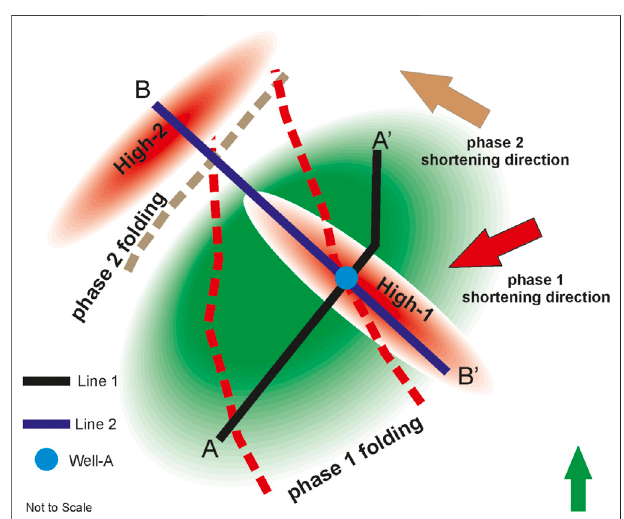
FIGURE 10 | Schematic drawing of the structural components of study area. Red dotted line represents phase 1(12.2 – 8.95 Ma) fold axes that trend roughly North – South. Brown dotted line represents the phase-2 (8.2 – 0.0 Ma) folding axes which trends southwest-northeast. Phase 1 shortening direction istowards thesouthwest, phase 2 shortening direction isnorthwest. Line1doesnotintersectthefoldaxisofphase2folding,whileLine2intersects both phase 1 and 2. Green area represents the minibasins found within the study